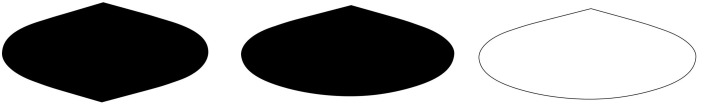
The Lemon Illusion is seen in shapes with convex regions that do not have constant curvature.